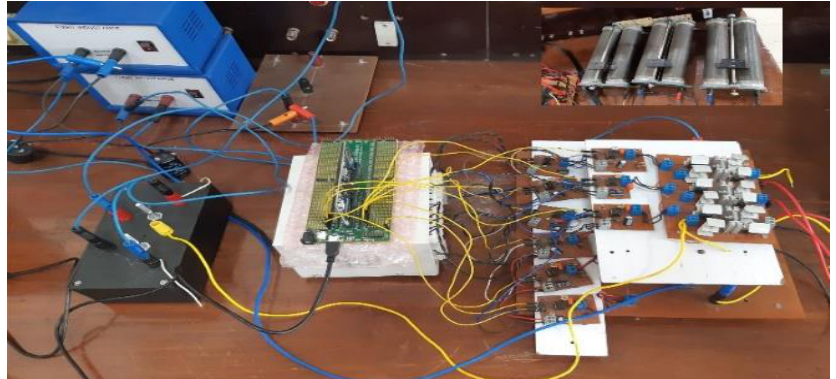
Figure 15. Experimental setup.